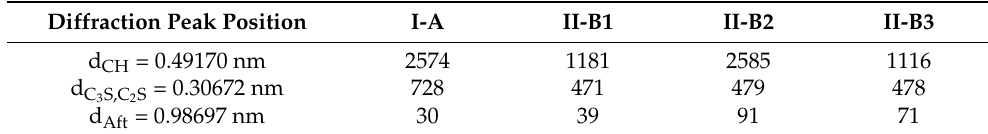
Figure 5. Seven-day XRD analysis of cement paste mixed with a single early-age strength component. Table 5. Comparison of hydration degree of 7-day cement paste.